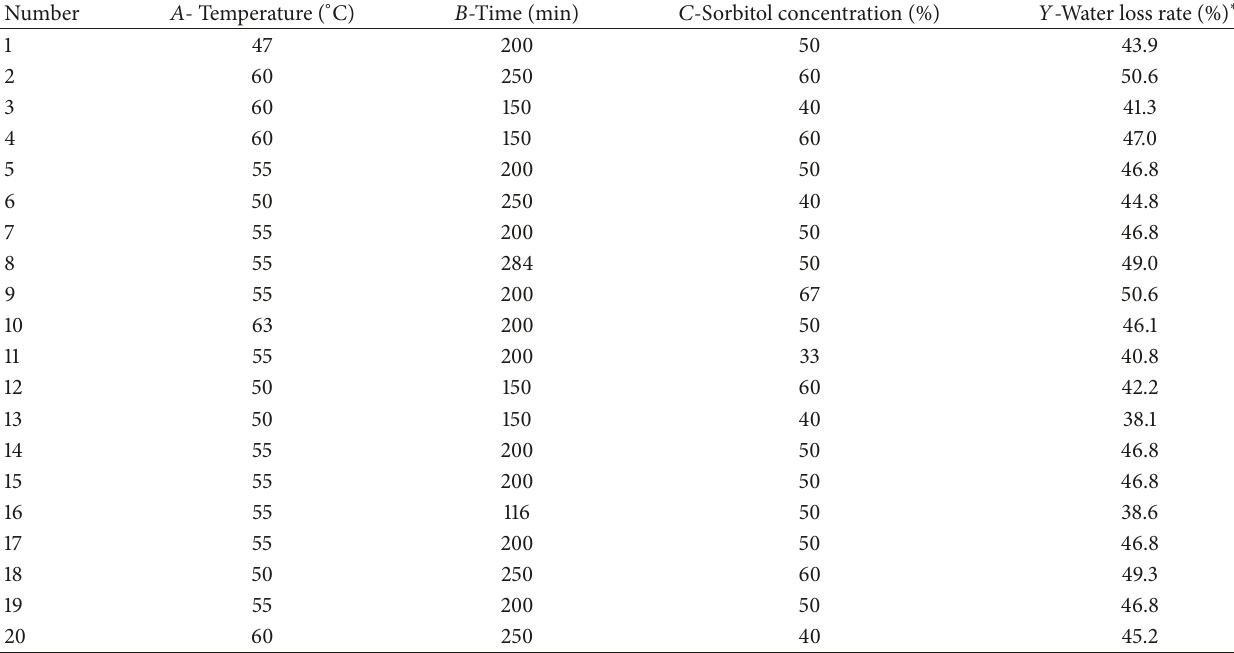
Table 2: Experimental design and experimentally obtained values of WL rate for strawberry osmotic dehydration.